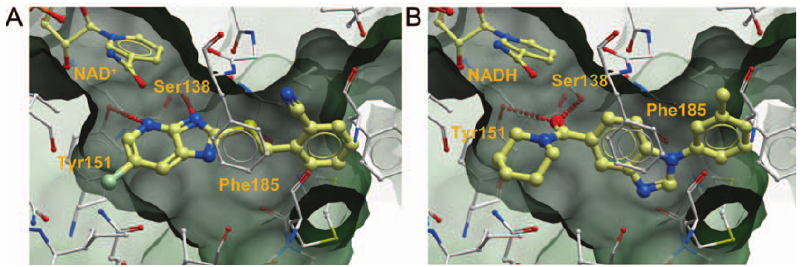
Figure 6. Binding of the inhibitors 61 ( A ) and 13 ( B ) in the active site of 15-PGDH as predicted by docking studies. The view shows a cut-through into the substrate pocket of 15-PGDH, with the volume of the pocket indicated by a green mesh. Key amino acid residues (see text) are labeled. Compounds and amino acid sidechains are in ball and stick representation, with the atoms color-coded: blue, nitrogen; red, oxygen; silver, bromide; white, carbon atoms in side chains; yellow, carbon atoms in compounds; green, carbon atoms in the cofactor. The figures were created using ICM (Molsoft, LLC).